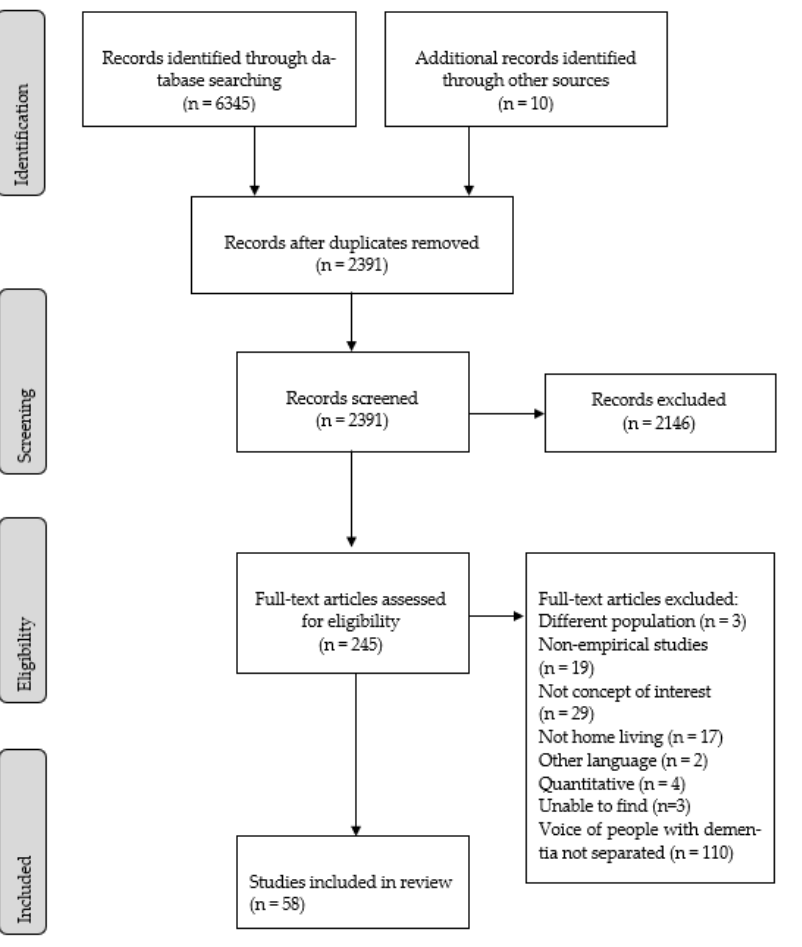
Figure 1. PRISMA flow diagram.